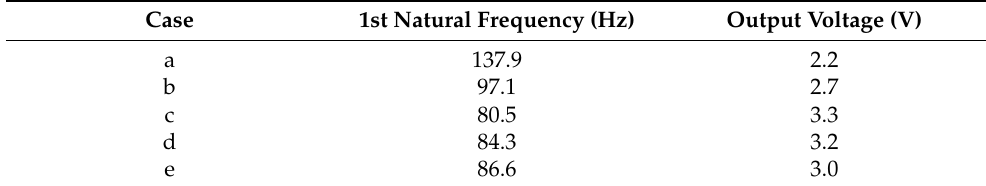
Figure 8. The output voltage vs. the frequency for five different piezoelectric materials. Table 3. The amount of voltage harvested from various studied geometries.